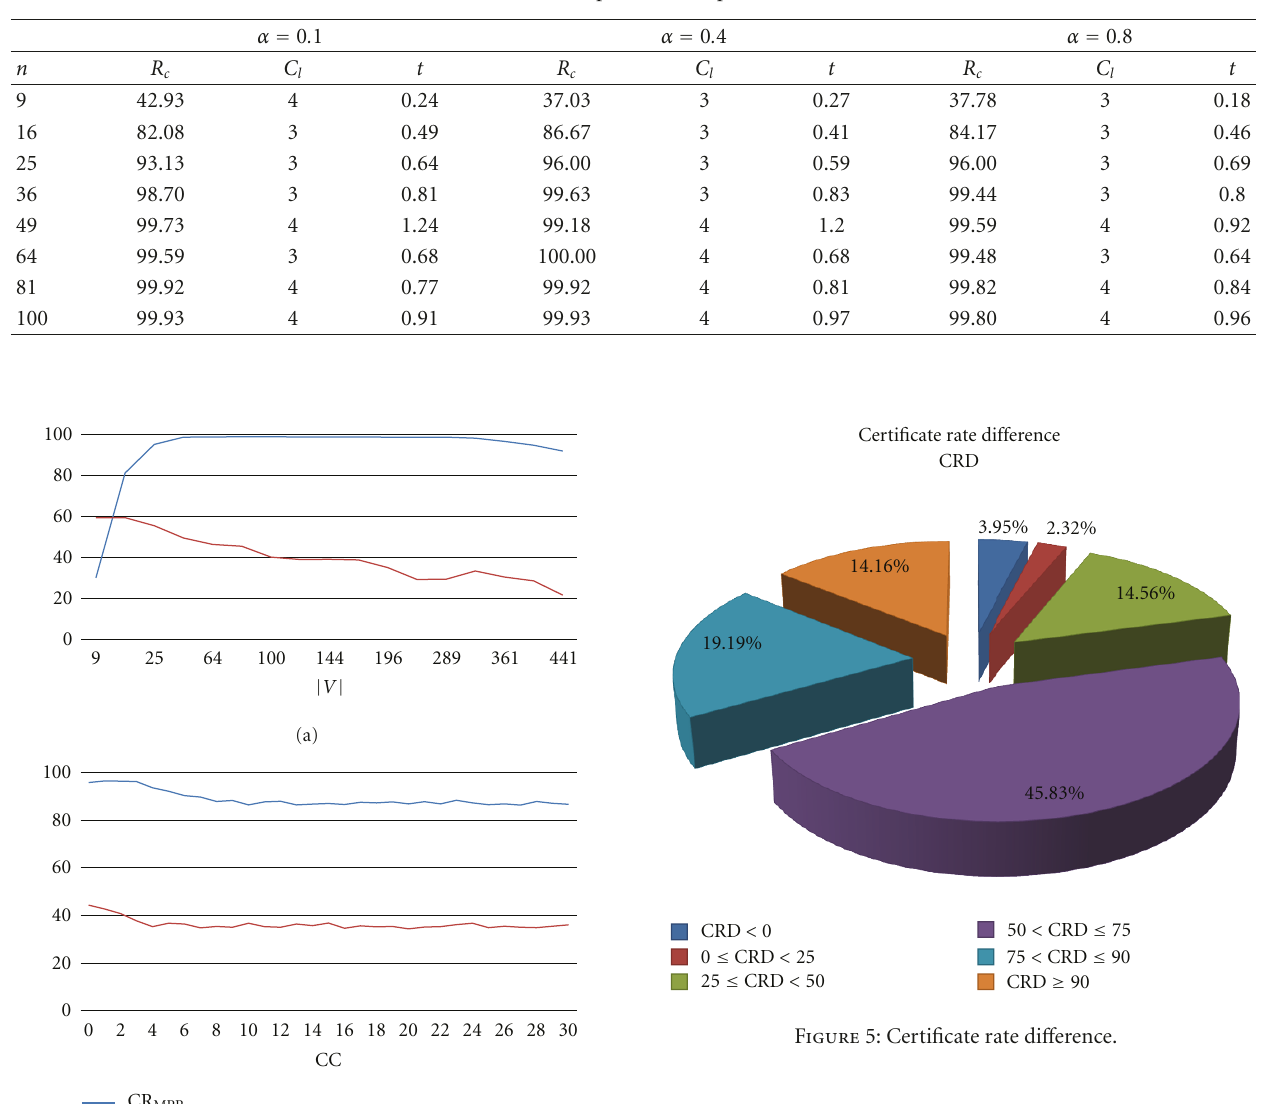
Table 1: Computational Experience.